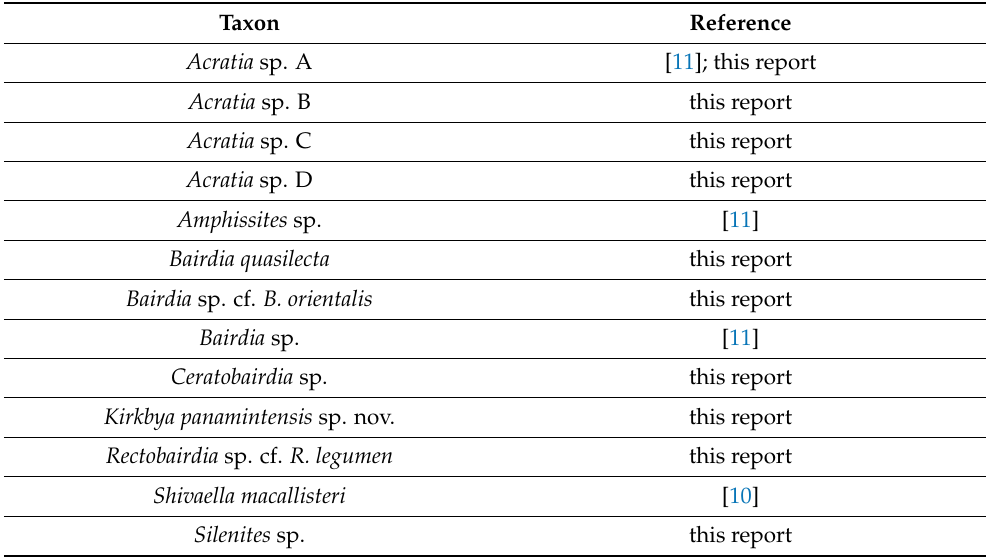
Table 1. Ostracod fossils illustrated in the literature from the Tin Mountain Limestone, eastern California,